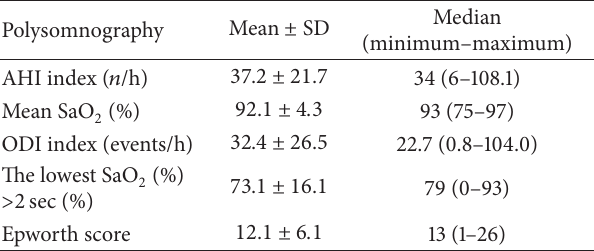
Table 2: The results of